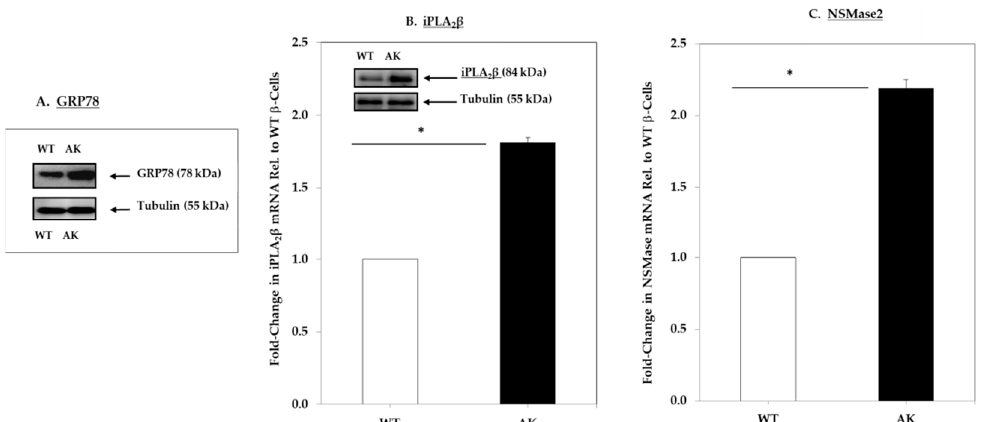
Figure 3. GRP78, iPLA 2 β , and NSMase expression in wild-type (WT) and Akita (AK) β -cells. Protein and cDNA were prepared from WT control and AK and analyzed as in Figure 1: ( A ) ER stress marker GRP78 protein, ( B ) iPLA 2 β message, and protein ( inset ); ( C ) NSMase2 message. (* Significantly different from WT control, p < 0.05). Data are presented as mean ± SEM, n = 3 per group.